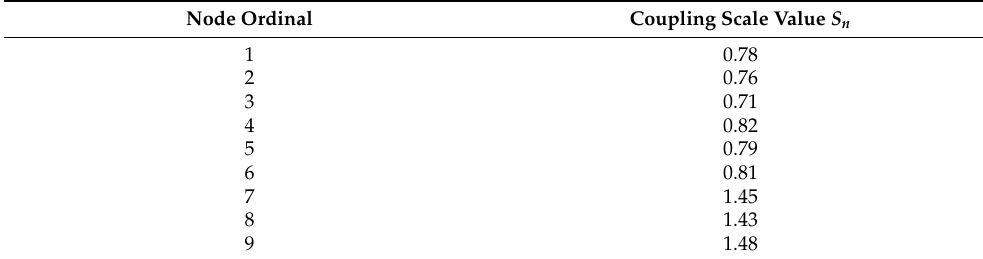
Table 1. Node scale value of the two-network coupling model.